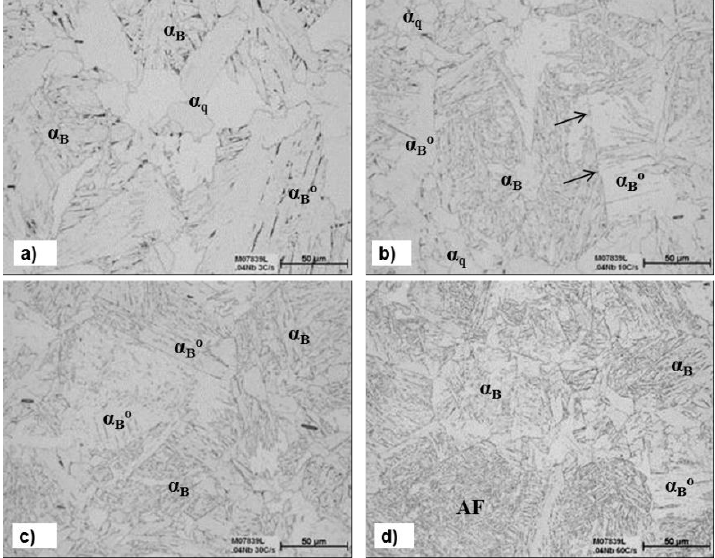
Figure 8. Optical microstructures for 0.04% Nb UCS dilatometer samples cooled at ( a ) 3 °C/s α q + α B , ( b ) 10 °C/s α q + α B + α B ° (arrows point out PAGB), ( c ) 30 °C/s α B + α B ° + AF and (d) 60 °C/s α B + α B ° +